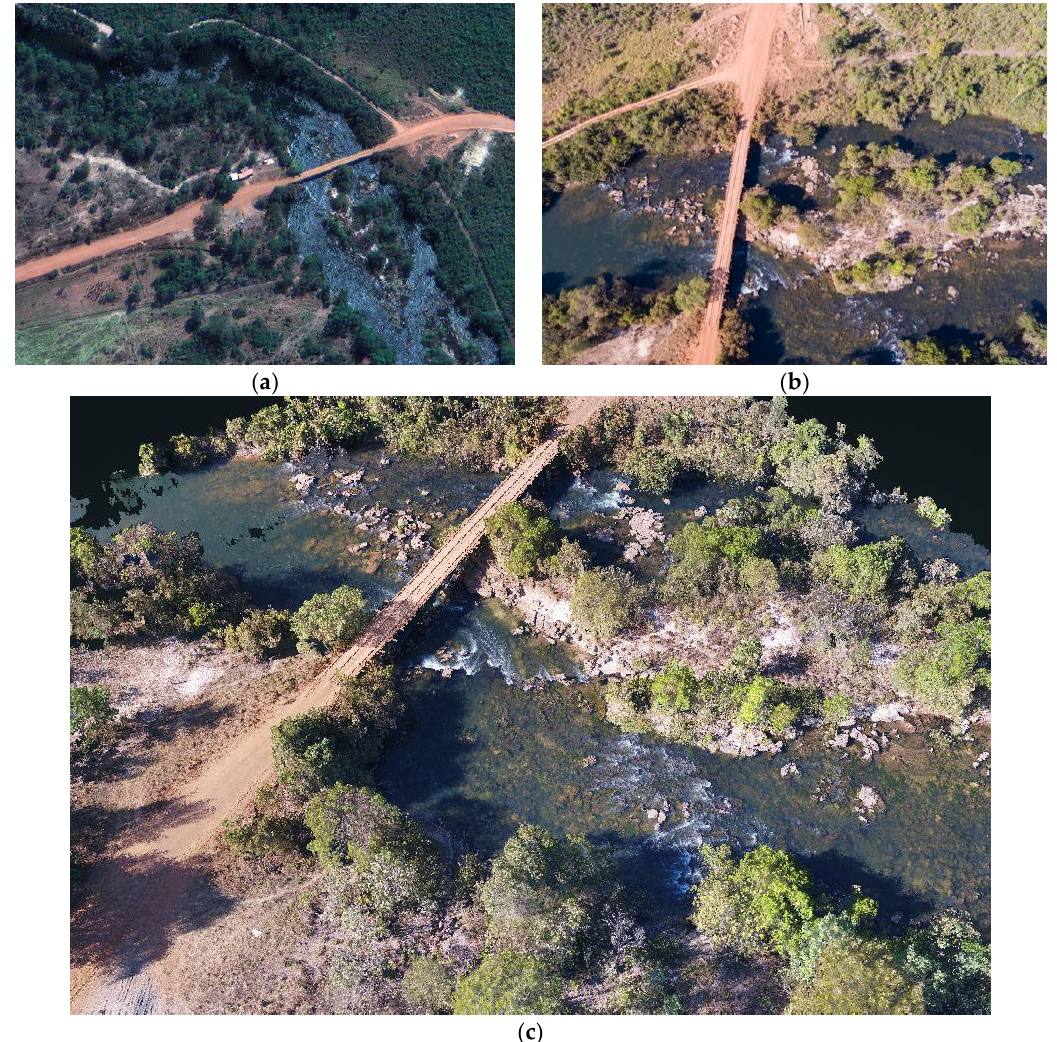
Figure 7. ( a ) Pansharpened GeoEye satellite image (50 cm panchromatic, 2 m multispectral) acquired 11 August 2017 of the Jatobá study site. ( b ) UAV photograph acquired 2 August 2017. ( c ) Densified 3D point cloud (1.2 cm GSD) generated from UAV SfM-MVS analyses using 375 photographs. The substrate (medium and large boulder classes) is visible in the shallow clear water. The interactive point cloud is available at: https://bit.ly/riojatoba.